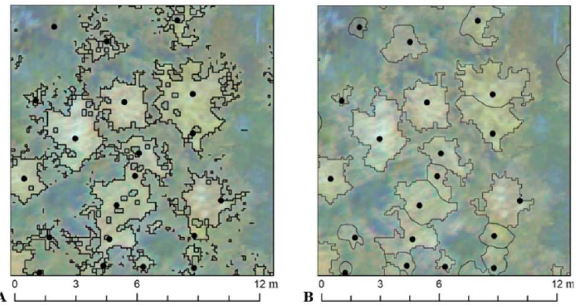
Figure 2. An example of crown delineation: (A) Derived contour lines from Maximum likelihood classification for tree crowns; (B) Corrected and digitized polylines. (Black dots representing tree stem